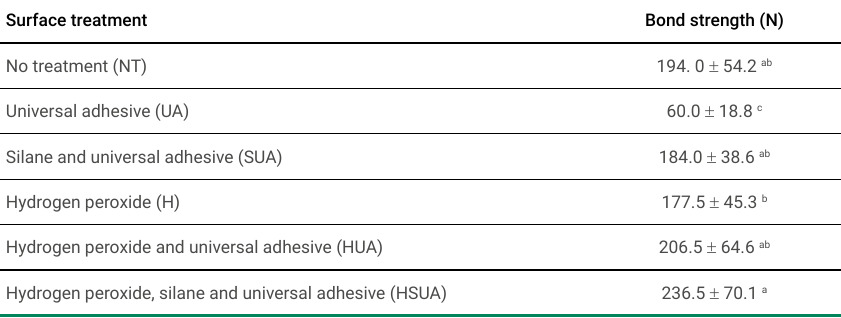
Table 1. Mean values and standard deviations of bond-strength, according to the glass fiber surface treatment. Surface